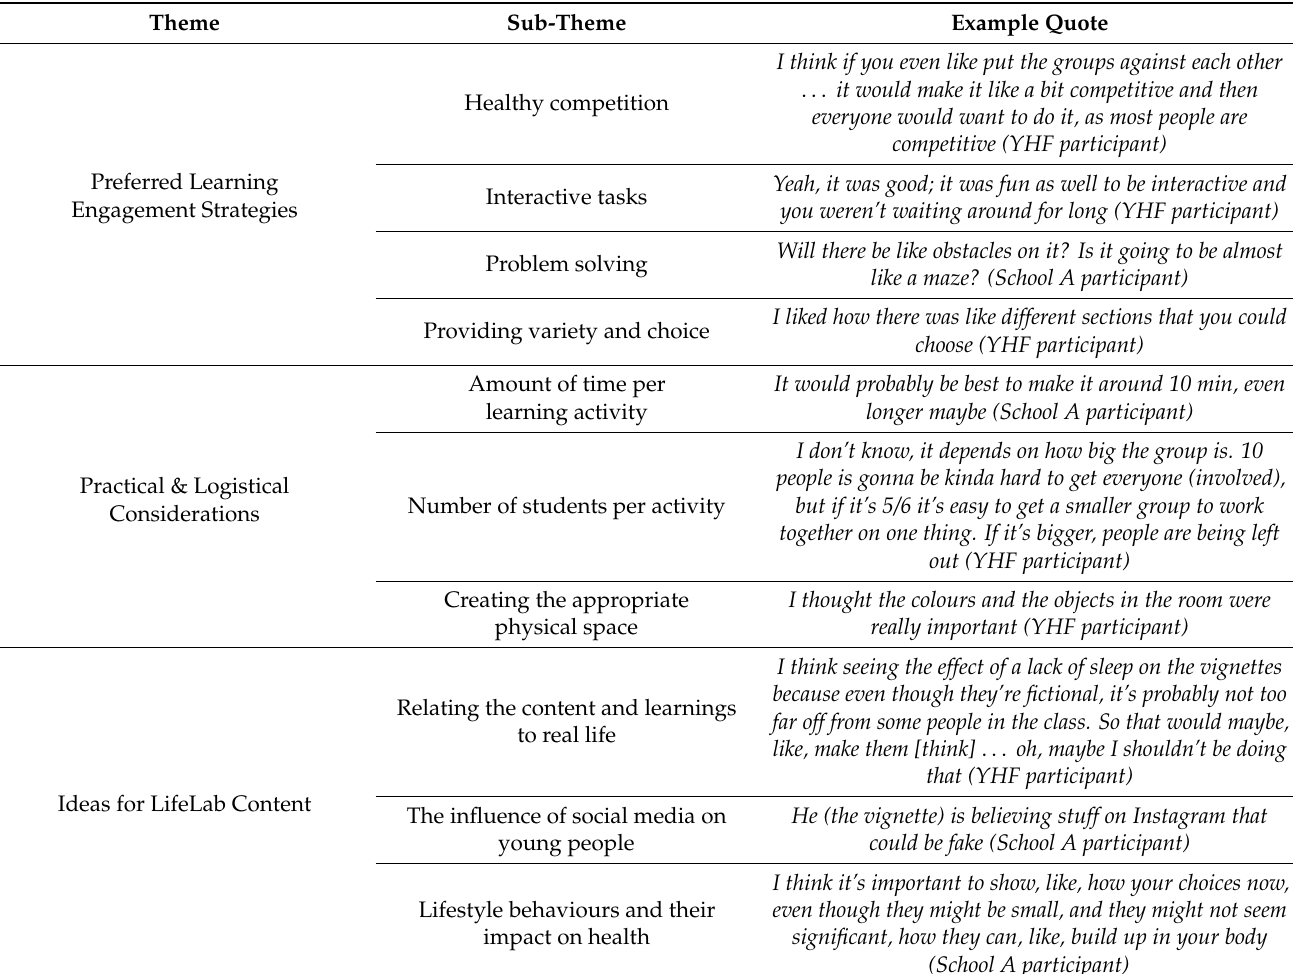
Table 1. Themes and